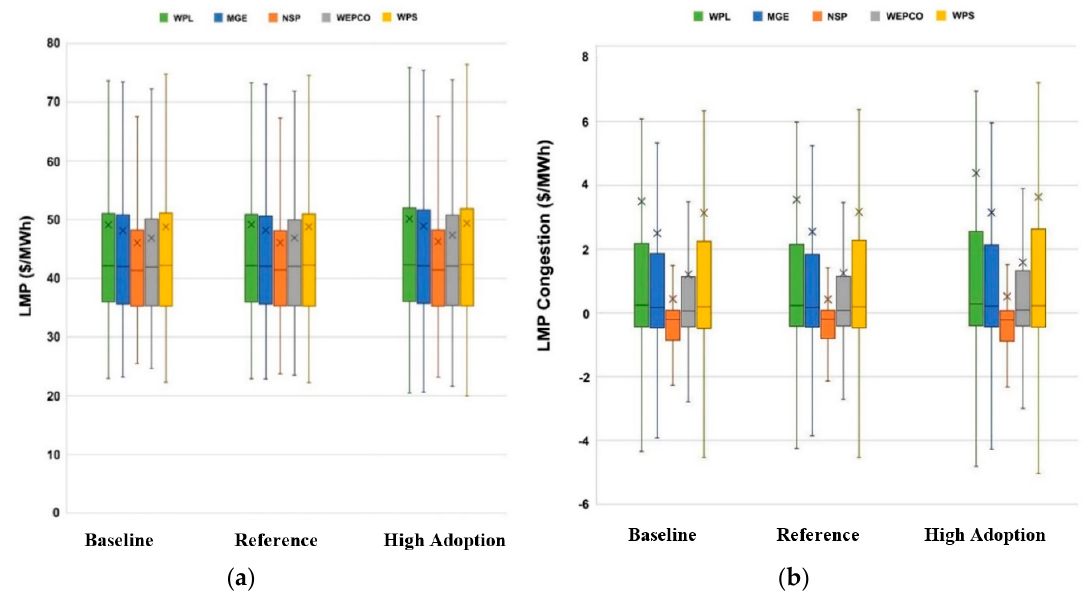
Figure 5. Total hourly LMPs ( a ) and congestion LMP component ( b ) on load buses of each Wisconsin service territory given all growth scenarios in 2030.